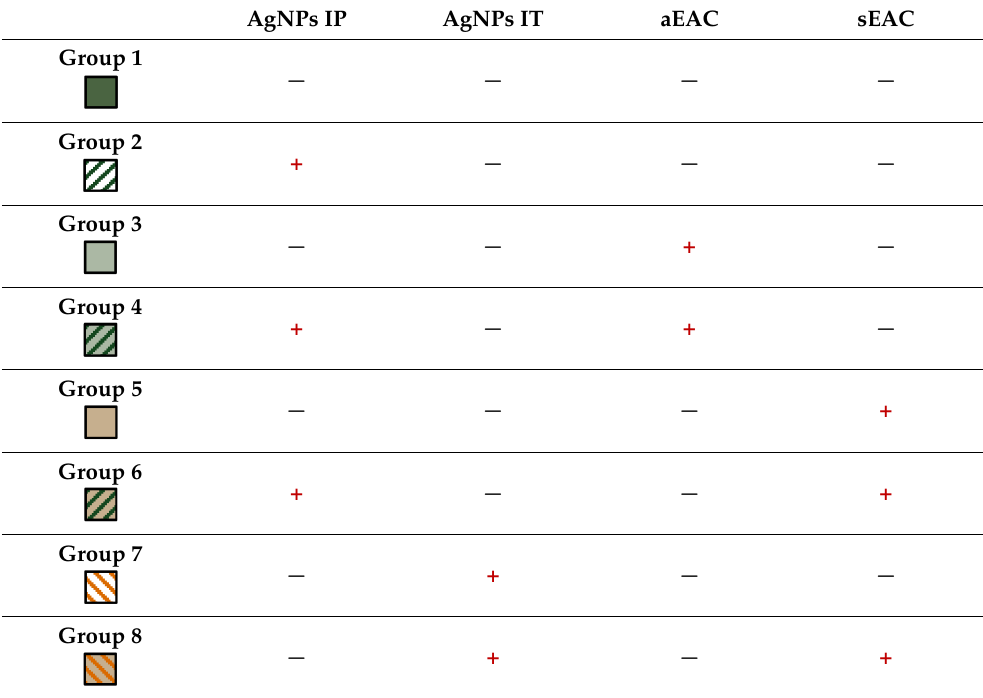
Table 1. Groups of mice formed to study AgNPs effect on copper status and copper-related genes expression in mice bearing ascitic or solid tumors.